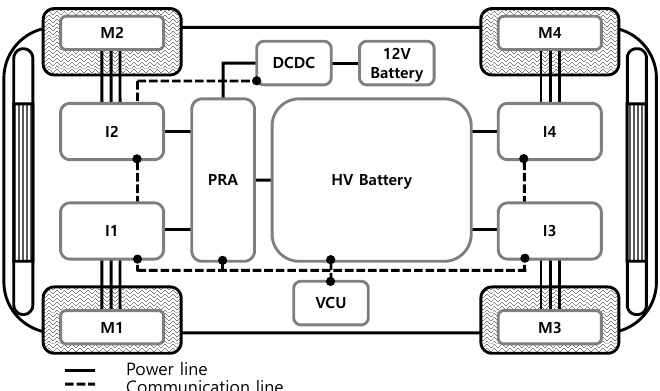
Figure 1. System architecture of the target electric shuttle bus. VCU: Vehicle Control Unit; M1 to M4: In-wheel Motor; I1 to I4: Inverter; PRA: Power Relay Assembly; DCDC: DCDC Converter; HV: High Voltage.